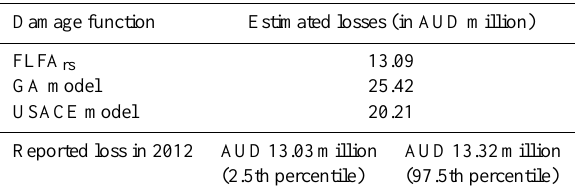
Table 4. Comparison of different loss estimates with the observed flood damage (95% confidence interval) on residential building structures for the flood event of February 2012. Note: for model validation, FLFA rs has been derived by the most-likely functional parameters.